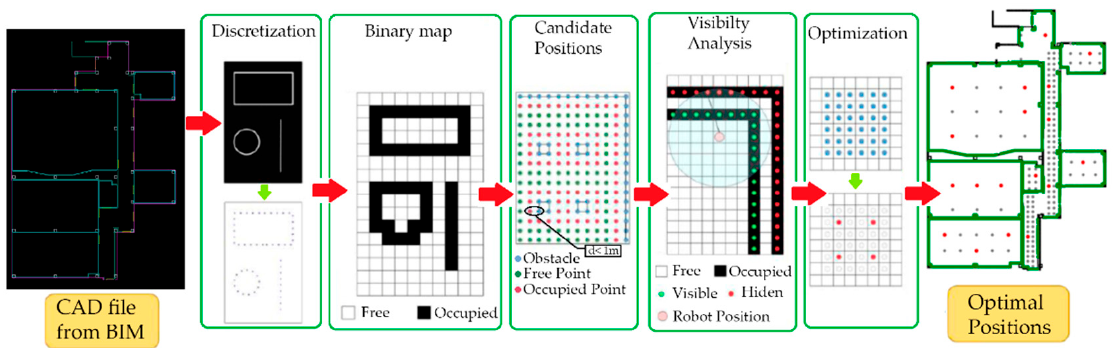
Figure 3. Path-planning workflow.